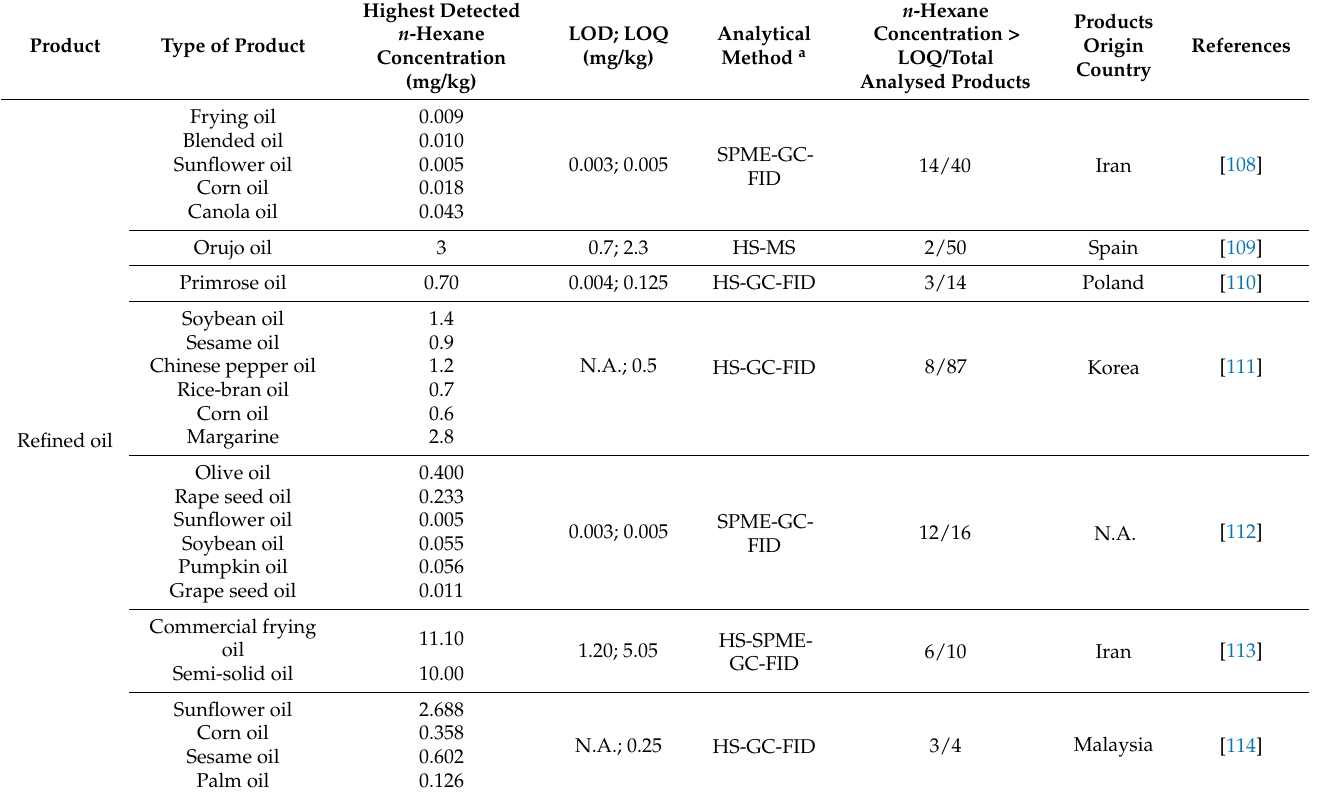
Table 5. n -Hexane residues in food and health food